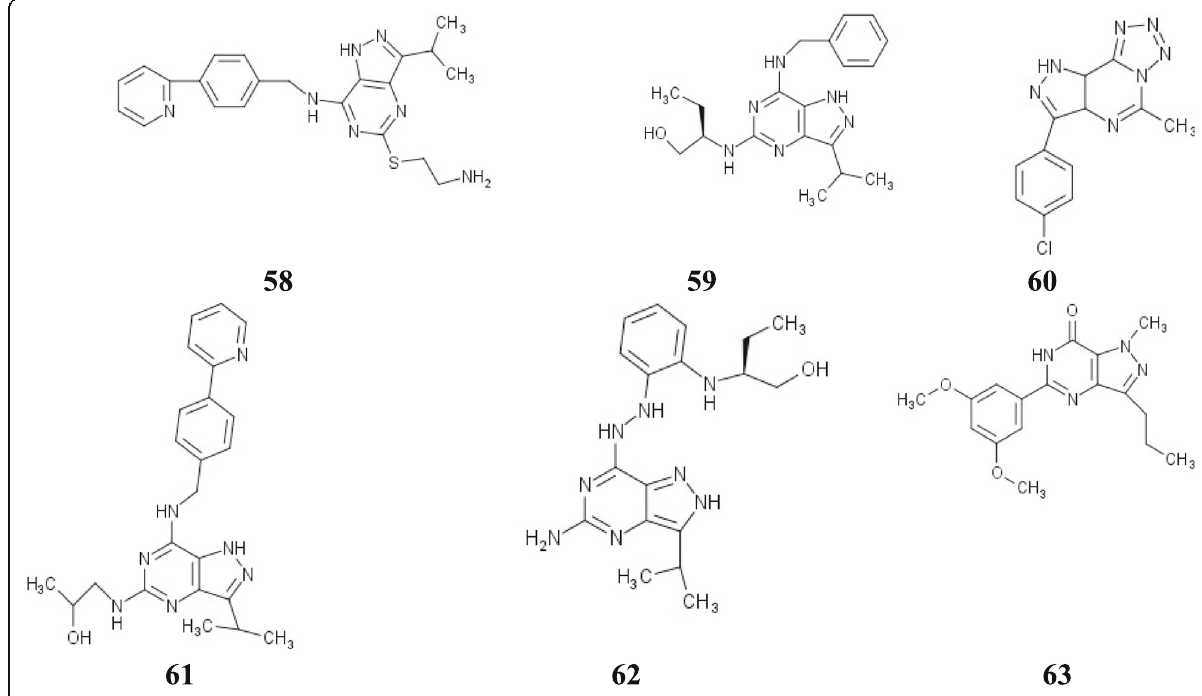
Fig. 19 Chemical structures of substituted pyrazolo [4, 3-d]